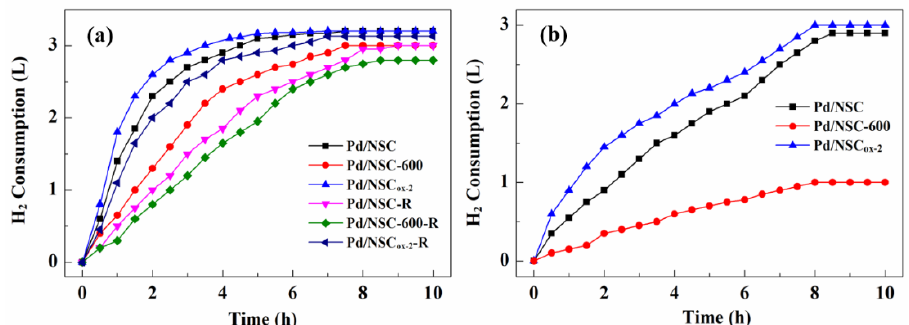
Figure 1. Hydrogen consumption amounts as functions of time during the hydrogenolysis reaction of TADB with fresh catalysts ( a ) and re-used catalysts ( b ), respectively.